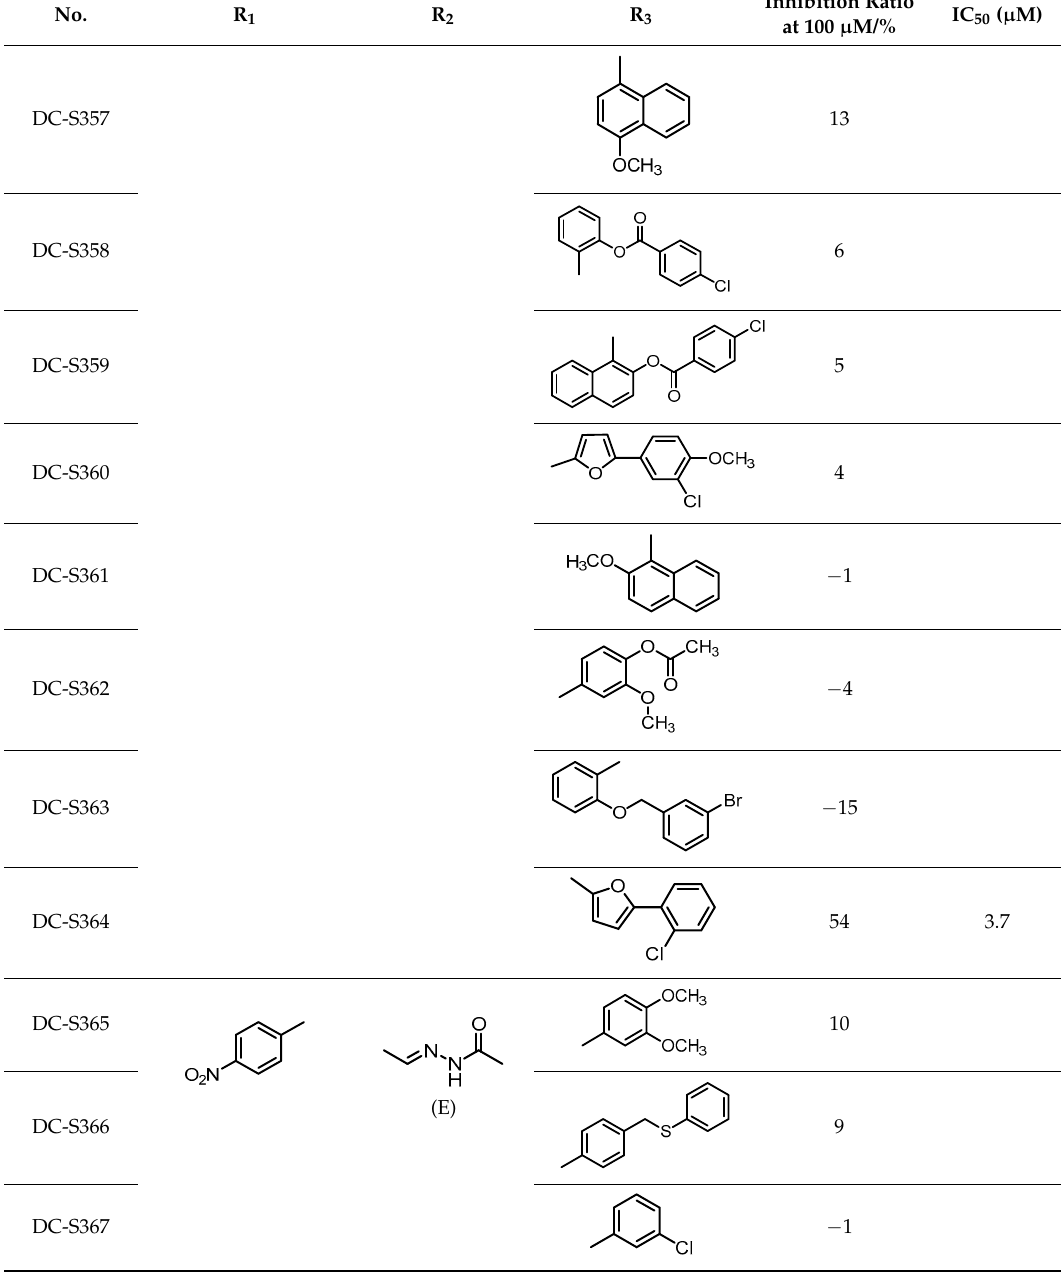
Table 3. Selectivity of DC-S303 over other epigenetic targets.